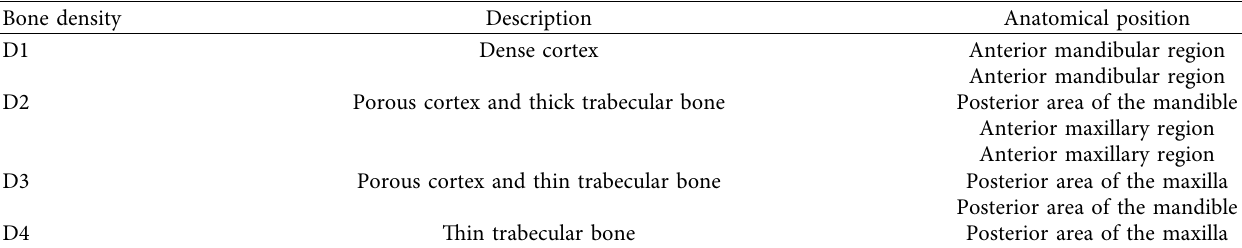
Figure 1: Model overview for M12 and Astra Tech implants. Table 2: Classification of bone density [32].